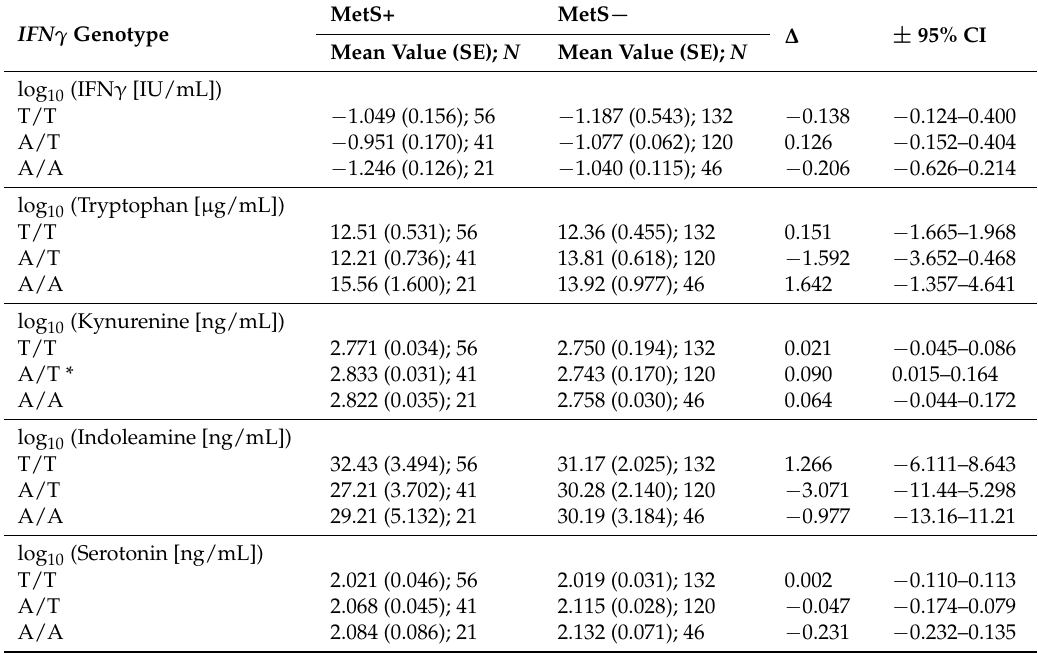
Table 3. Analysis of the relationships between the IFN γ gene rs2430561 polymorphism and the levels of IFN γ -inducible inflammatory cascade markers with regard to